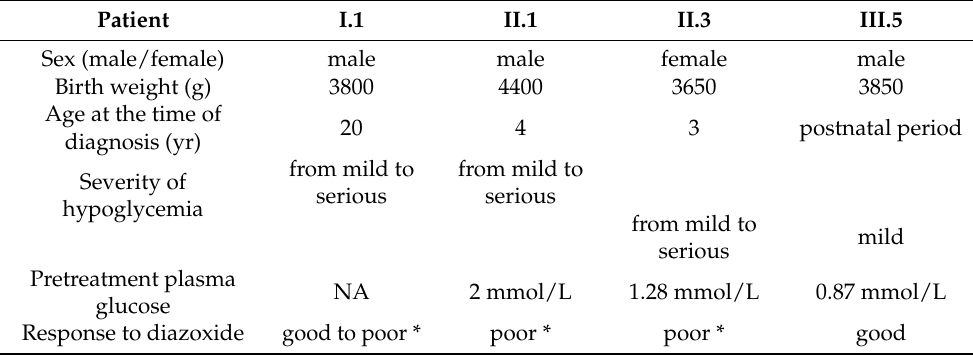
Table 1. Clinical characteristics of affected family